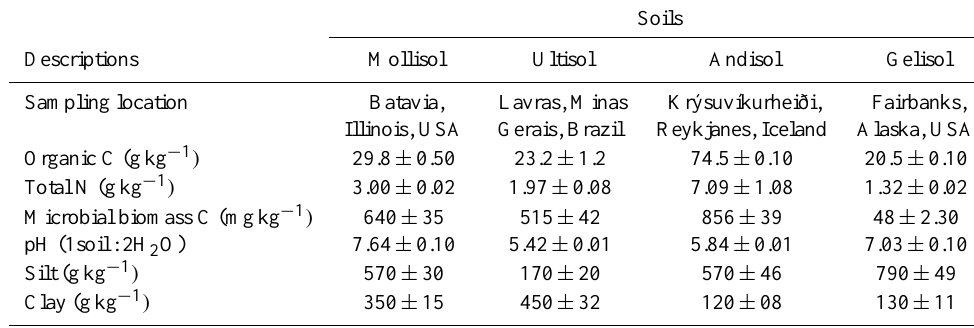
Table 1. Sampling locations and pre-incubation soil